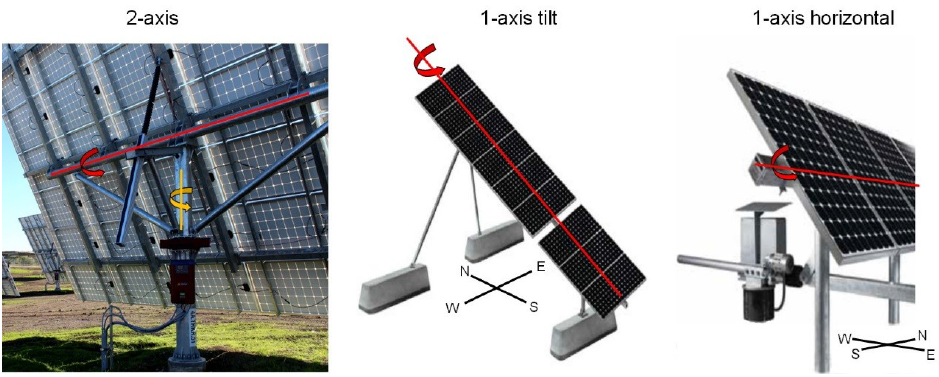
Figure 16. Three types of PV trackers defined by tracking dimension.